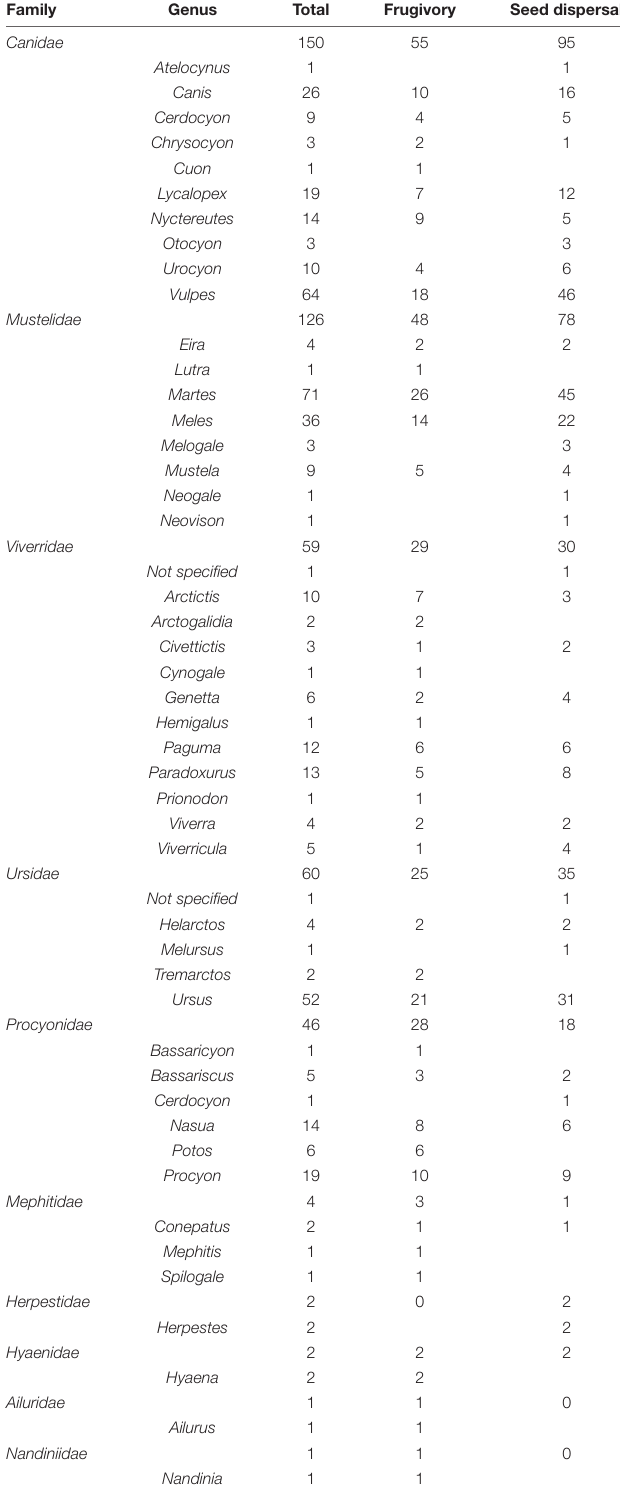
TABLE 1 | Breakdown of the distribution of studies we found in our literature search described in the introduction by family and genus, and whether those studies looked at seed dispersal or frugivory in each taxonomic group.